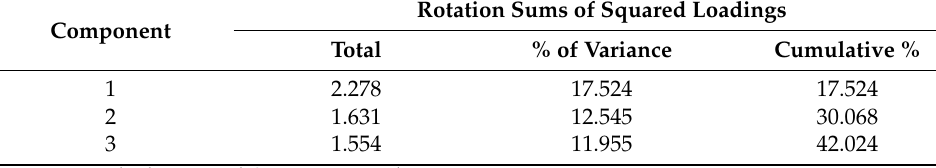
Table A5. Total Variance Explained.